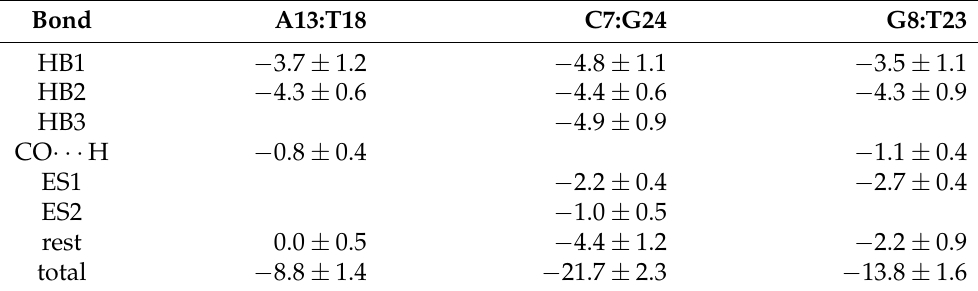
Table 5. Interactions ∆ E ij (kcal mol − 1 ) between functional groups forming hydrogen bonds (HBs), CO · · · H bonds, and electrostatic (ES) bonds in selected base pairs in the protein–DNA complex, averaged over 100 snapshots of the MD trajectory a .